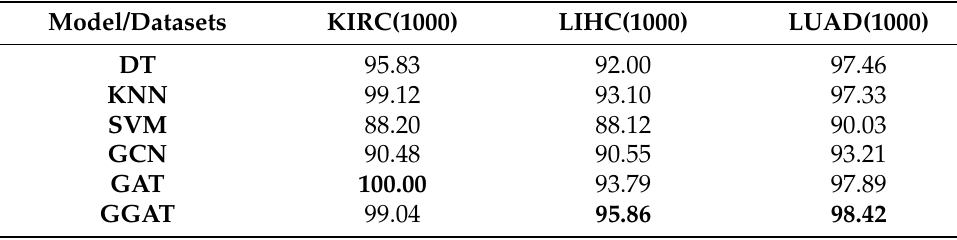
Table 13. Accuracy (%) of Models Under 1000 Feature